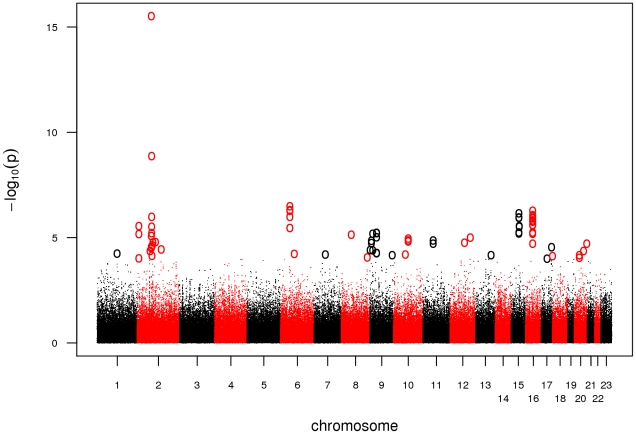
Manhattan plot of the GWA.Association results of the GWA stage. The x-axis represents genomic position along the 22 autosomes and the x-chromosome, the y-axis shows -log10(P) for each SNP assayed. SNPs with a nominal λ-corrected P<10−4 are highlighted as circles.